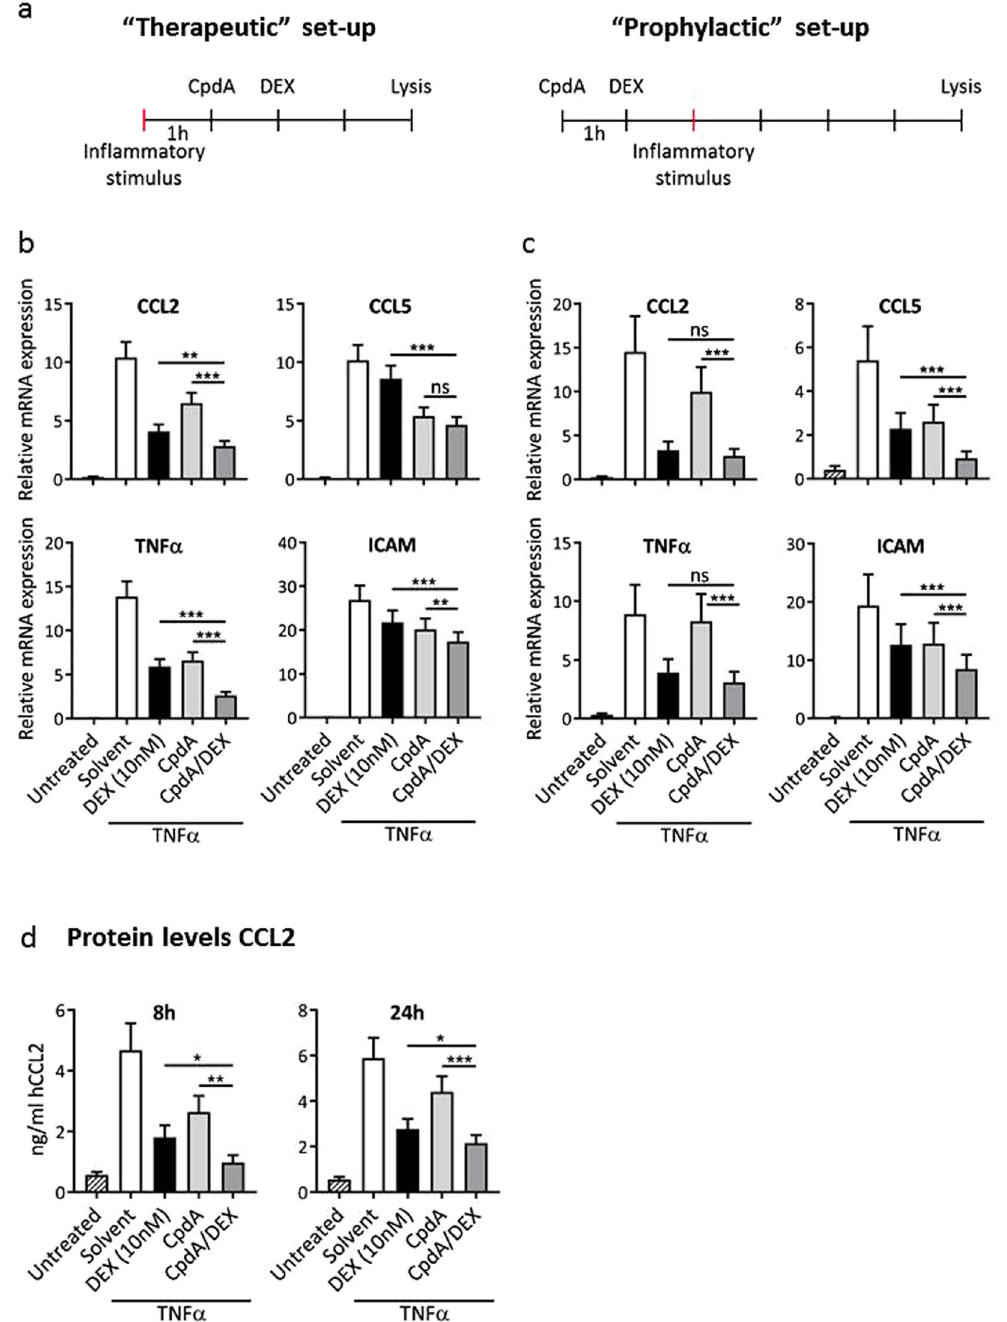
Figure 2. Combining CpdA with a non-saturating DEX concentration suppresses particular inflammatory genes, both at the mRNA and protein level. ( a ) Scheme of the experimental set-ups. ( b ) A549 cells were sequentially stimulated with TNF α (2000 units/ml for 4 h), CpdA (10 µ M) and DEX (10 nM) with 1 h between stimulations. Total RNA was extracted and subjected to RT-qPCR. Expression values were normalized to the reference genes Cyclo and HPRT using qBase + . Five independent replicates were performed. Means + SE, obtained as predictions from the HGLMM fitted to the data, are shown on the original scale for CCL2, CCL5, TNF α and ICAM. ( c ) A549 cells were sequentially stimulated with CpdA (10 µ M, for 6 h), DEX (10 nM) and TNF α (2000 units/ml) with 1 h between stimulations. Total RNA was extracted and subjected to RT- qPCR. Expression values were normalized to the reference genes Cyclo and HPRT using qBase + . At least four independent replicates were performed. Means + SE, obtained as predictions from the HGLMM fitted to the data, are shown on the original scale for CCL2, CCL5, TNF α and ICAM. ( d ) A549 cells were sequentially stimulated with TNF α (2000 units/ml for 8 or 24 h), CpdA (10 µ M) and DEX (10 nM) with 1 h between stimulations. Culture supernatant was harvested and measured with sandwich ELISA for CCL2 protein. Three independent replicates, normalized using a standard curve, were performed. Means + SE, obtained